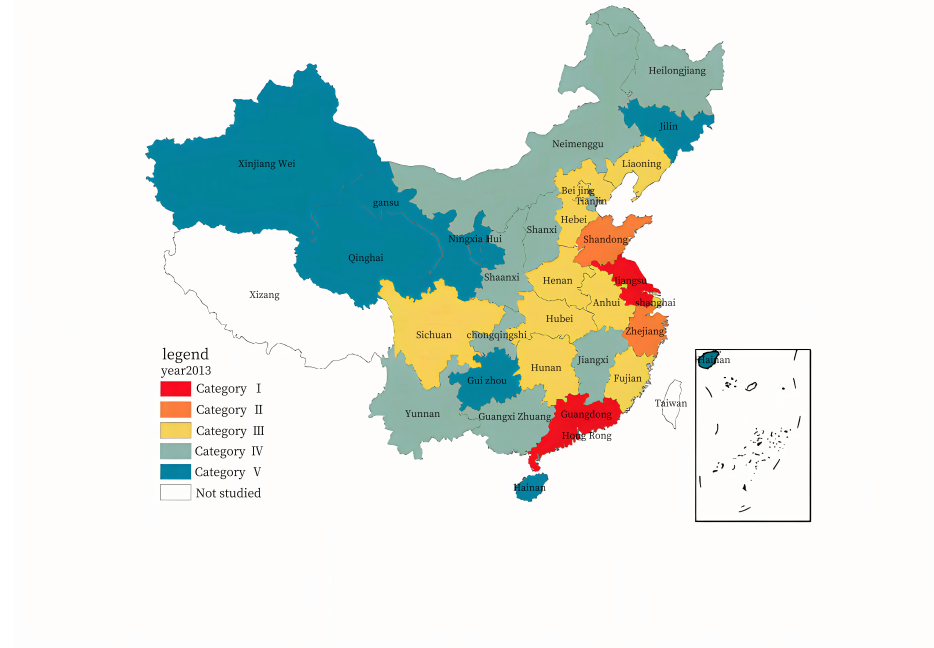
Figure 5. Spatial distribution for the RLGILs of the 30 provinces in